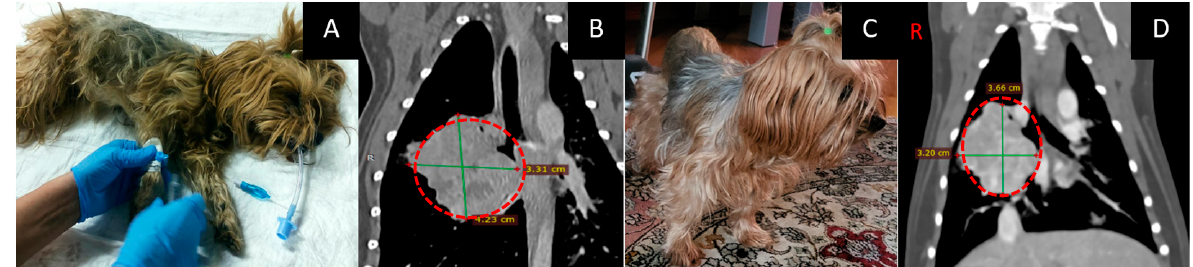
Figure 5. Female dog “Lily” (13 years old) with a tumor of unknown origin (pathological examination was not done) in the middle lobe of the right lung with involvement of the cranial and caudal lobes and single metastases to the lungs and regional lymph nodes Animal preparation for GdNCT ( A ). Chest CT ( B ) before irradiation showed a tumor 33 × 35 × 42 mm in size (green lines, dashed red circles). Animal appearance after irradiation ( C ). Two months after GDNCT, chest CT scans ( D ) showed that the tumor mass decreased in size to 32 × 38 × 36 mm (dashed line).